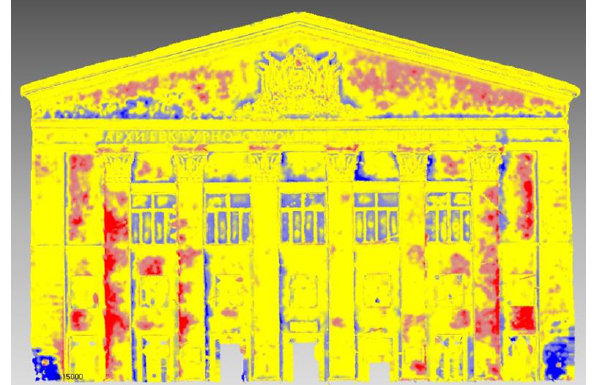
Figure 8. Map of the mean square deviations between three- dimensional vector models